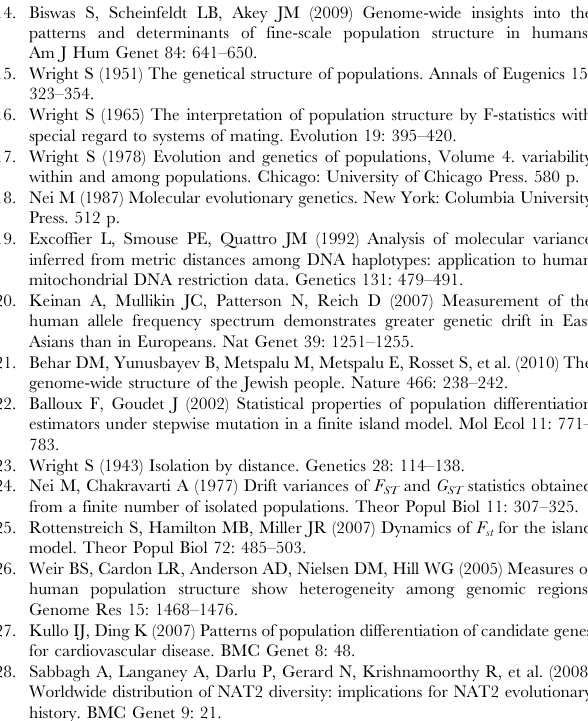
Figure S2 Fitting the expected cumulative distribution function of an exponential distribution to the F ST distribution. The two distributions largely overlap. (TIF) Figure S3 F ST values of SNPs from the continental dataset versus their expected exponential values. F ST values were calculated for all SNPs (red), excluding rare ones (MAF , 0.05) (blue) for autosomal (a) and X-chromosomal (b) SNPs. (TIF) Figure S4 Distribution of locus-specific F ST in eight populations (CEU, CHB, CHD, JPT, LWK, MKK, YRI, and TSI). F ST values were obtained for a. 1,100,484 autosomal SNPs, and b. 32,650 SNPs on the non-recombining region of the X chromosome. The histograms show bin distribution as indicated on the x-axis and the cumulative distribution (line). (TIF) Figure S5 A histogram of the distances between adja- cent F ST . threshold SNPs for five allele frequency groups. (TIF) Figure S6 LD for five allele frequency groups as a function of physical distance in Europeans. LD ( r 2 ) in European populations is plotted as a function of physical distance on a log-scale for five allele frequency groups (a–e). To simplify the presentation, the mean and standard error of the mean r 2 for the F ST . threshold SNPs (blue) and F ST , threshold (red) are presented for different between-SNP distances (50 bp, 100 bp, 1 kb, 5 kb, 10 kb, 50 kb, 100 kb, 500 kb, and 1000 kb). F ST . threshold SNPs are marked as green dots. Figure S7 LD for five allele frequency groups as a function of physical distance in Asians. LD ( r 2 ) in Asian